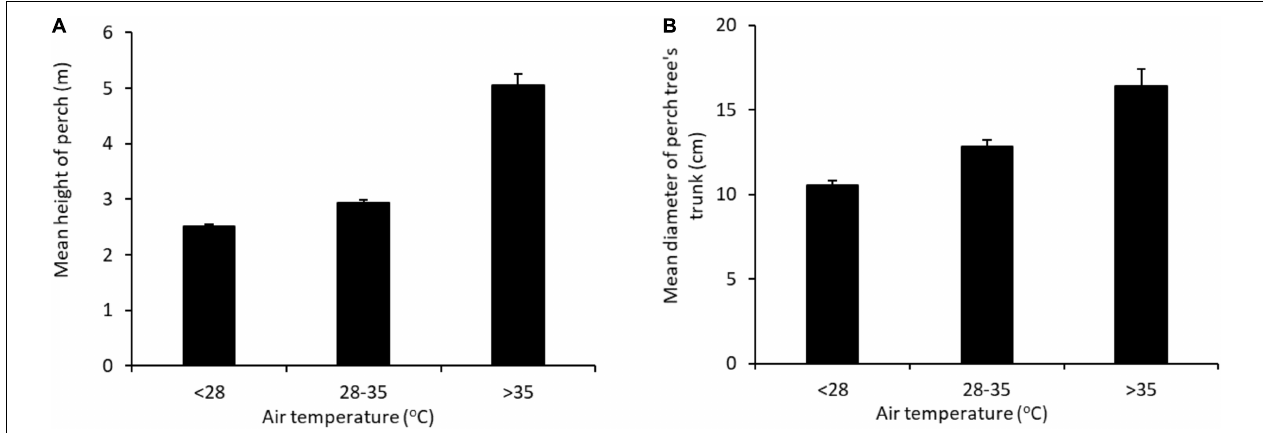
FIGURE 5 | Relationship between air temperature and (A) the mean height of perches and (B) the mean size of the perch tree (diameter of largest trunk at 1.5 m). Error bars show SE.